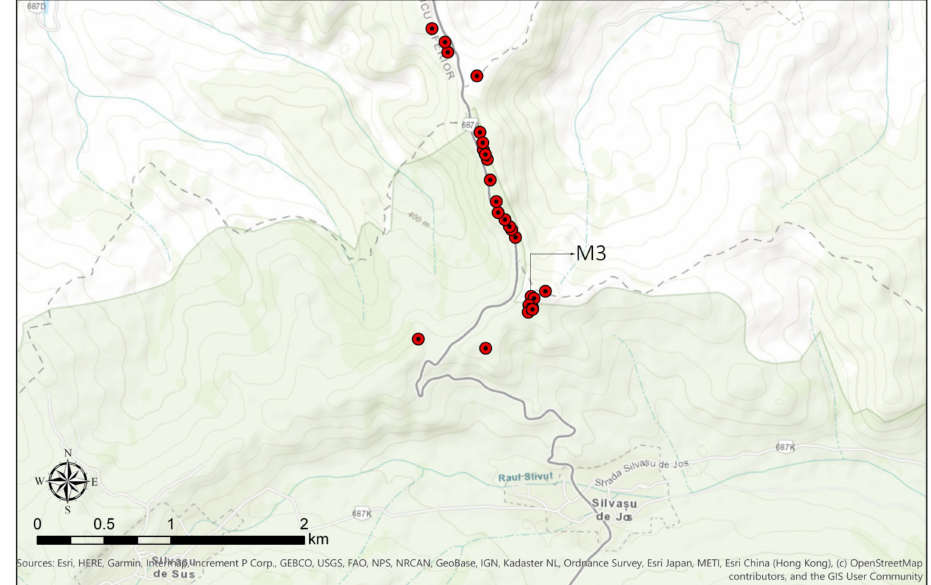
Figure 2. Distribution of discovered mounds within the